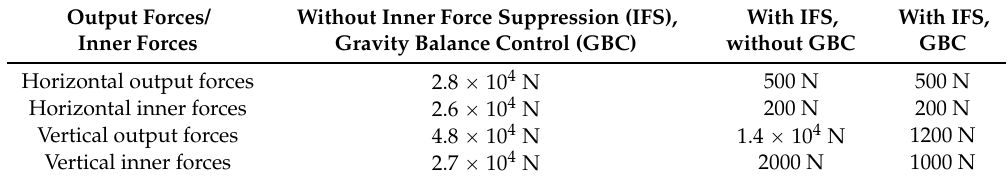
Table 2. The maximum inner forces and output forces with different controllers at 0 position.